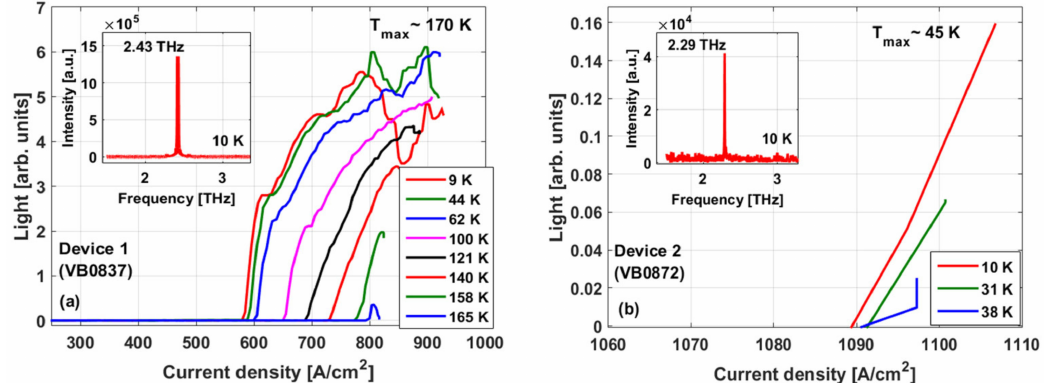
Figure 2. Pulsed light–current measurements of ( a ) Device 1 (VB0837, 1 × doping) and ( b ) Device 2 (VB0872, 2 × doping), with their lasing spectra shown in the inset boxes. Details of these structures can be found in Tables 1 and 2 and Figure